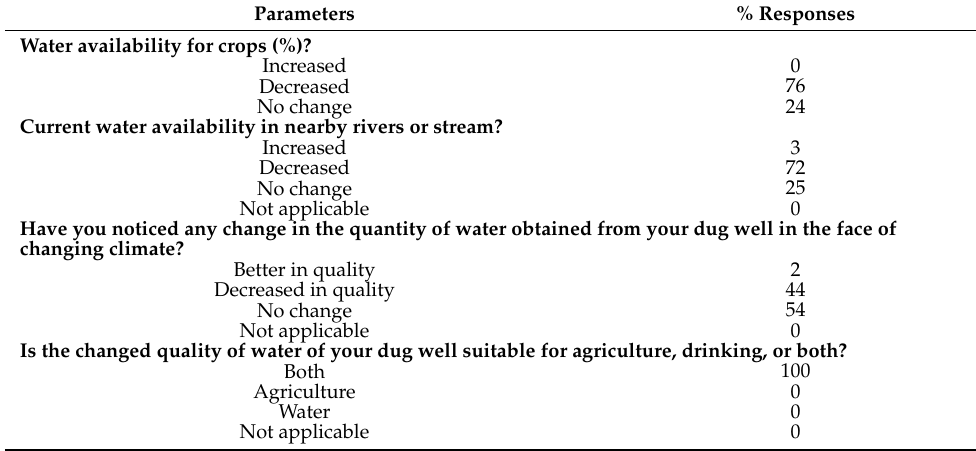
Table 10. Perception about climate change’s impact on water availability.